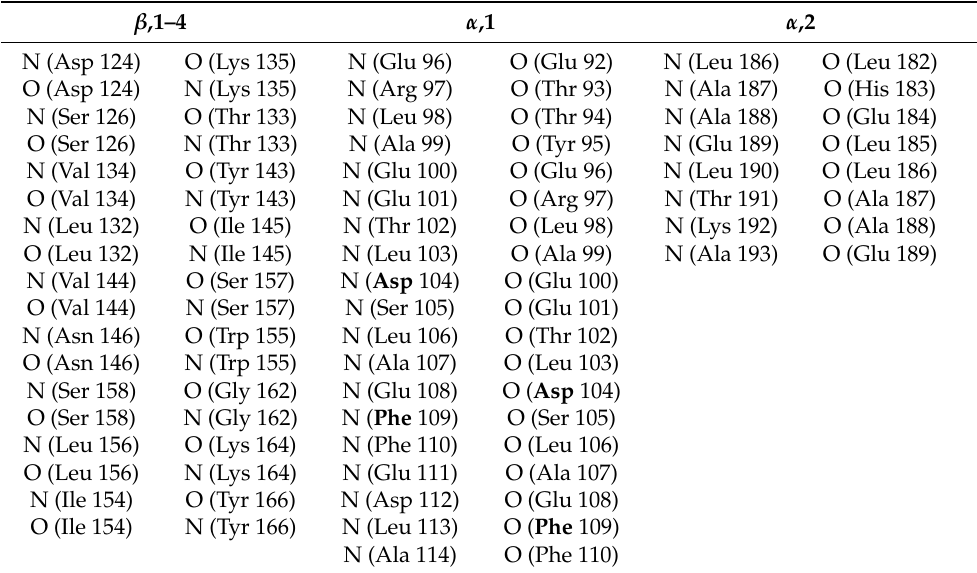
Table 1. Pairs of atoms used in Equation (16) and related label in parameter S . Residues are those of WT sequence. Mutated residues are boldface.